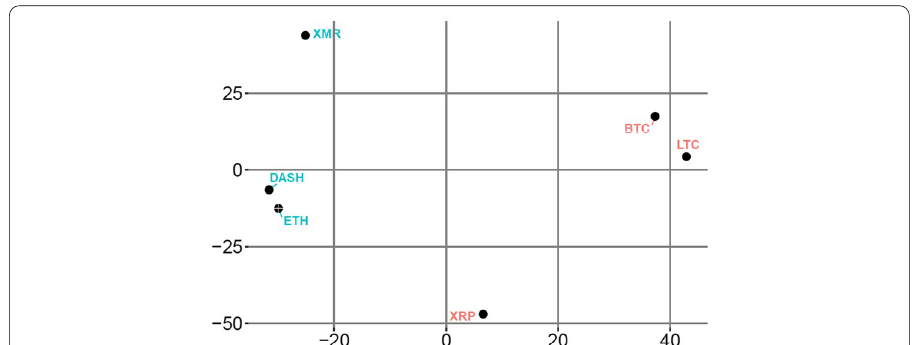
Fig. 2 Cluster based on decomposed DY approach. Note : This figure shows the symmetric part of the connectedness table for the full sample period. Two colours (red and blue) show two distinct risk clusters formed through hierarchical